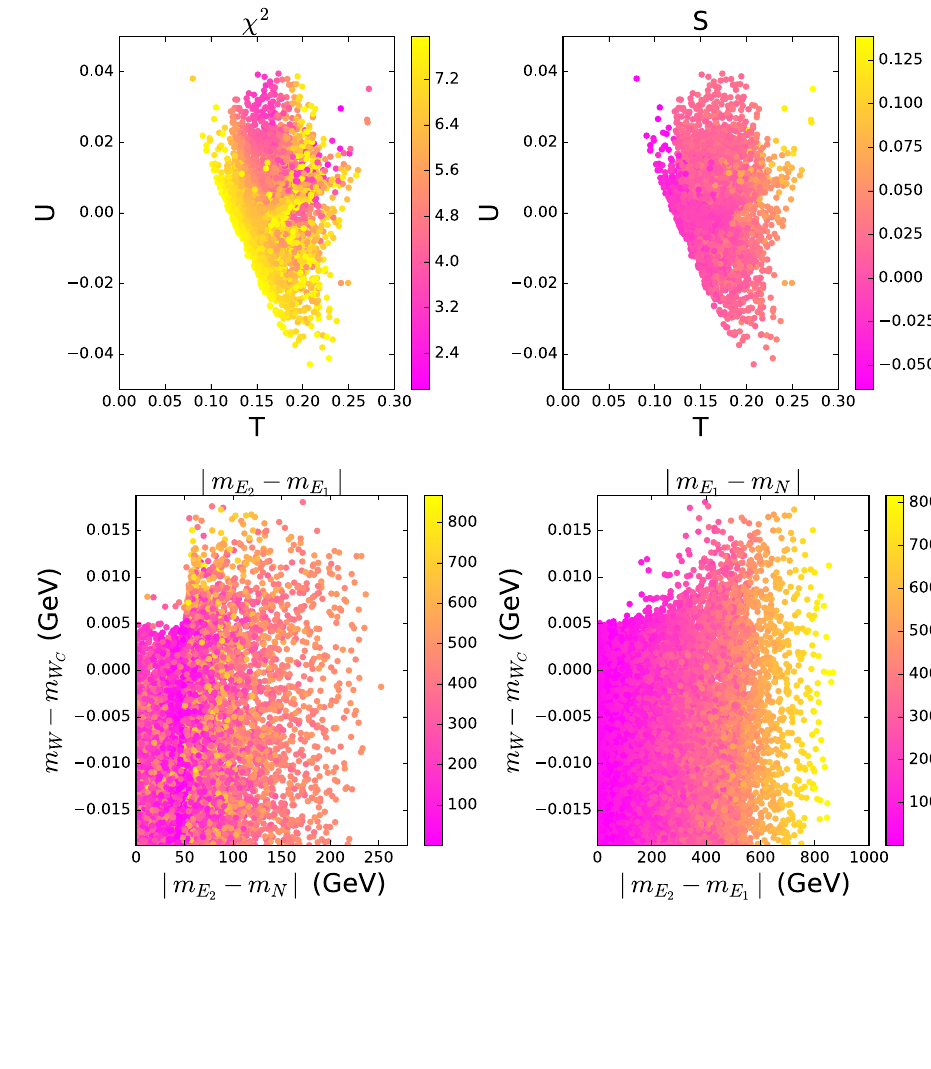
Fig. 3 Same as Fig. 1, but projected on the planes of m W − m | and versus | m E N 2 | m − m | . Here m E 2 E 1 W C denotes the central value of the CDF W -mass, 80.4335 GeV. The varying colors in each panel indicate the values of | m − m | and E 2 E 1 | m − m | , E 1 N